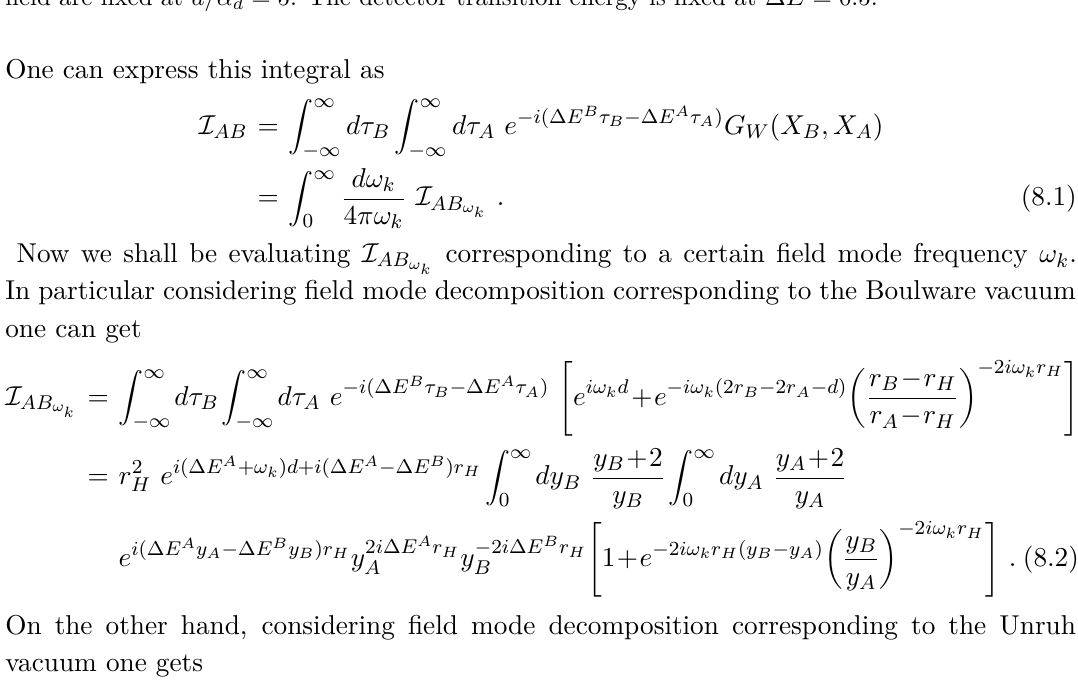
and |I − are plotted in green and blue lines, respectively Figure 31 . The quantities |I + | /r 2 | /r 2 H H E ωk E ωk for two outgoing null detectors in different parallel paths in a (1+3) dimensional de Sitter spacetime with respect to the separation between the two paths d/r . The dimensionless frequency of the H field are fixed at d/α = 5 . The detector transition energy is fixed at ∆ E = 0 . 5 d